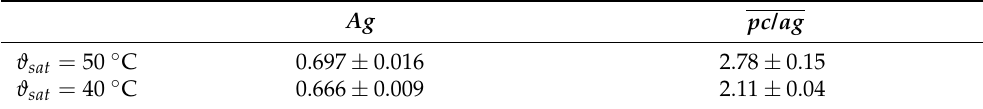
Table 3. Agglomeration degree ( Ag ) and number of primary crystals per agglomerate ( pc / ag ) for different saturation temperatures in batch cooling crystallization. The end temperature is 20 ◦ C each. The error bars are calculated according to the three replicated crystallizations for each saturation tem- perature. Ag pc /